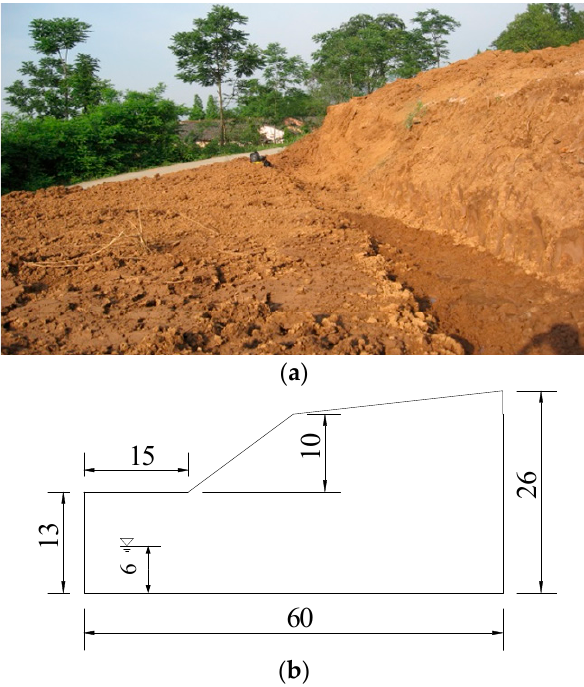
Figure 8. Typical expansive soil slope. ( a ) Slope. ( b ) Slope profile (unit: m). The corresponding finite element meshes are seen in Figure 9. The elements considered were 4-node quadrilateral elements. There were 1157 elements and 1236 nodes. The boundary conditions of the displacement were as follows. (1) The bottom was a fixed boundary. (2) The normal displacement of the left-to-right lateral boundary in the horizontal direction was set to zero. The constitution of the slope soil materials adopted the Mohr– Coulomb elastic–plastic strength criterion. Table 2 provides the mechanical parameters of the soil measured during the test. m was the effective coefficient of the equivalent expansive force, χ was the parameter of suction, and ϕ b was the internal friction angle of suction.